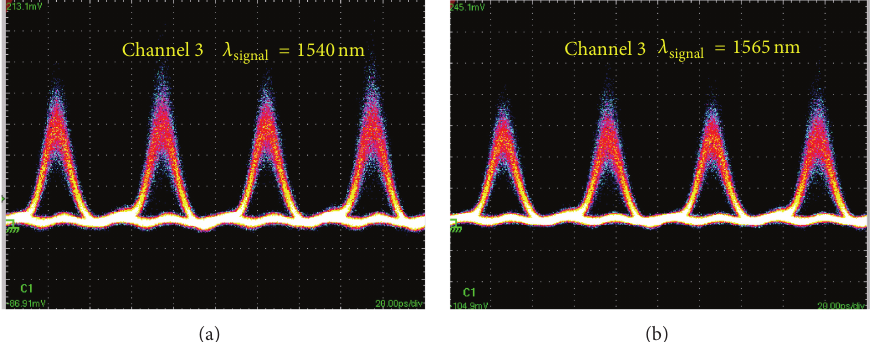
= 1540 nm and (b) 𝜆 = 1565 nm. Time base: signal signal